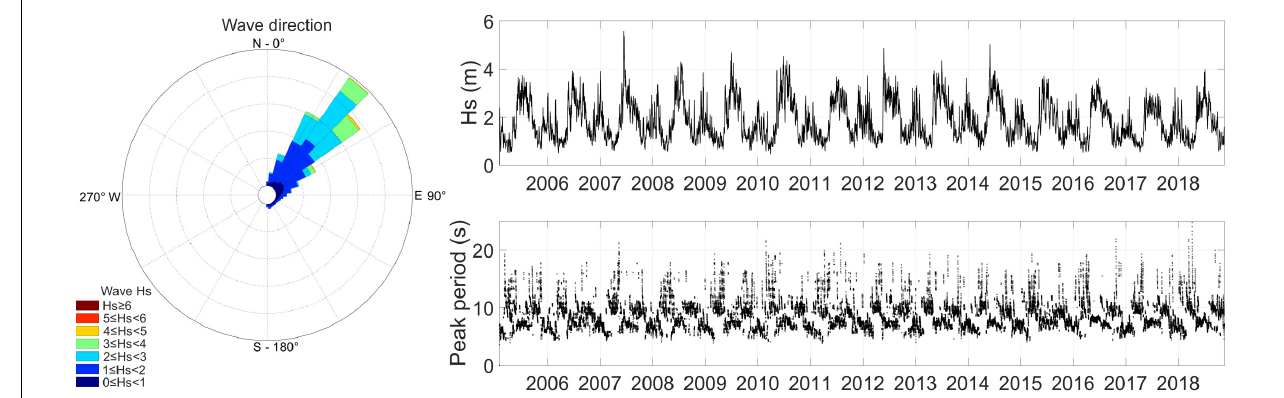
FIGURE 2 | Three hour averages of wave-climate parameters, H s and T s , derived from a 13 year (2006–2018) record of data extracted from the Wave Watch III model (WWIII, NOAA) for a point (5 ◦ 54 (cid:48) 14.85 (cid:48) N, 53 ◦ 48 (cid:48) 7.96 (cid:48)(cid:48) W) 20 km offshore of the mouth of the Maroni (see Figure 1A